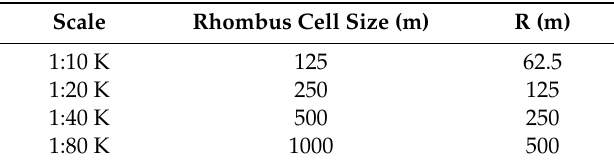
Table 3. Rhombus size and distance between soundings (R = half of the fishnet cell